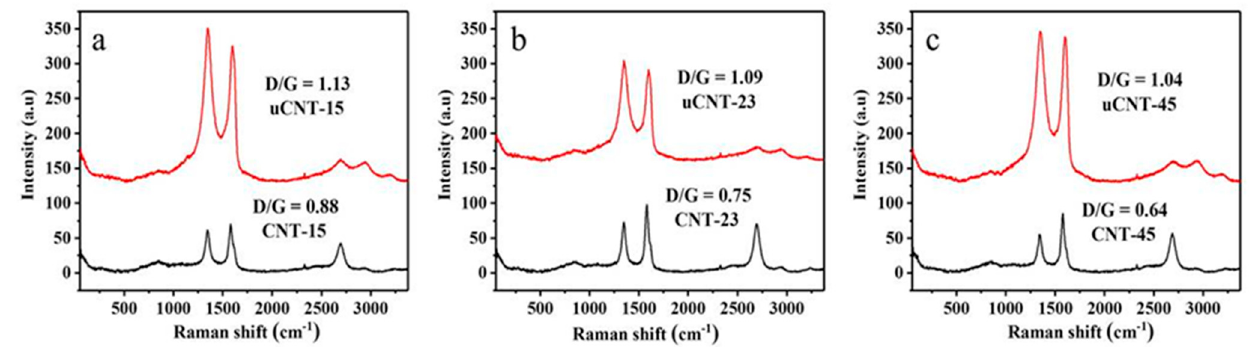
Figure 4. Raman spectra of CNT-15 and uCNT-15 ( a ), CNT-23 and uCNT-23 ( b ), CNT-45 and uCNT-45 ( c ).